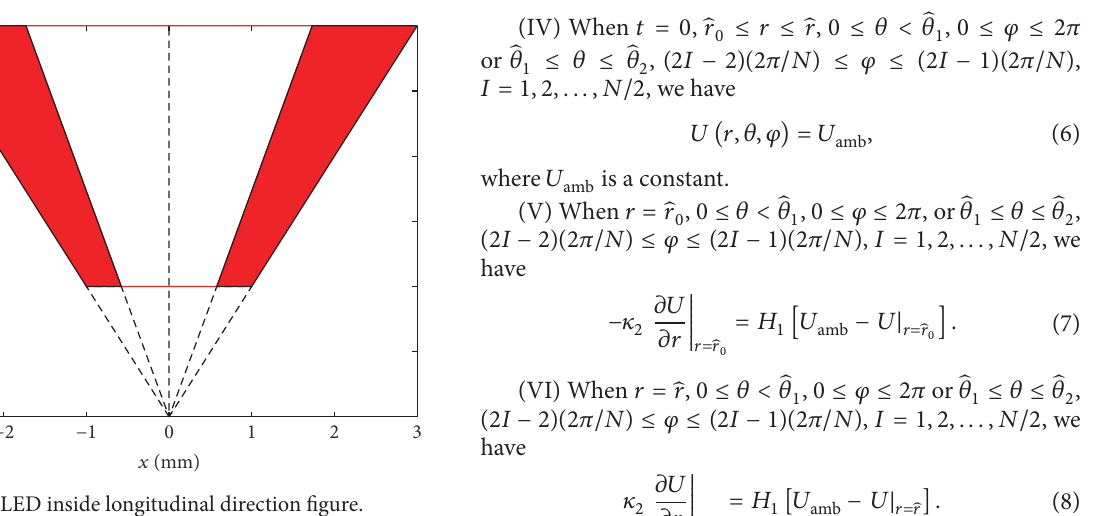
Figure 2: LED inside longitudinal direction